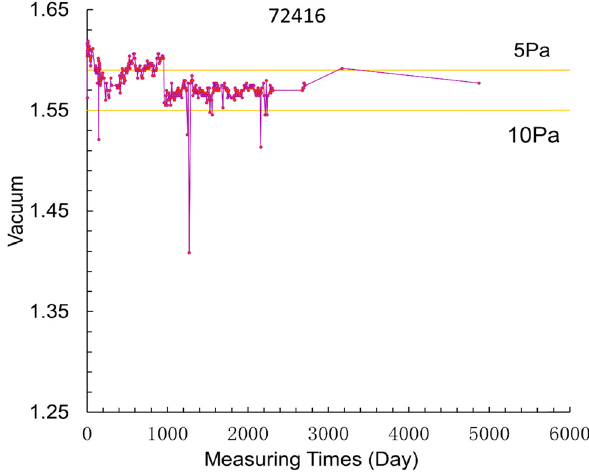
Figure A1: Relationship between vacuum holding voltage and time in No. 72406 vacuum packaging shell.